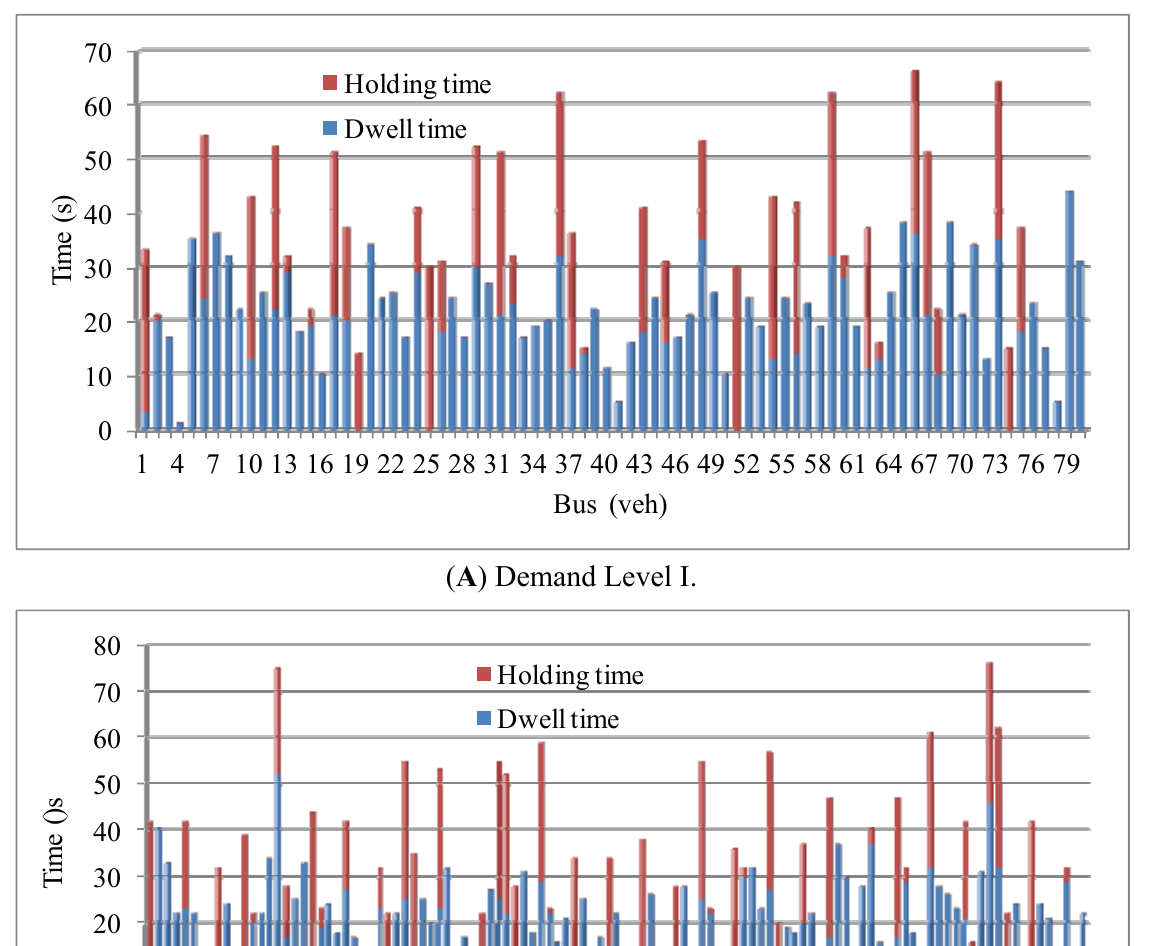
Figure 8. Comparison of recommended bus holding